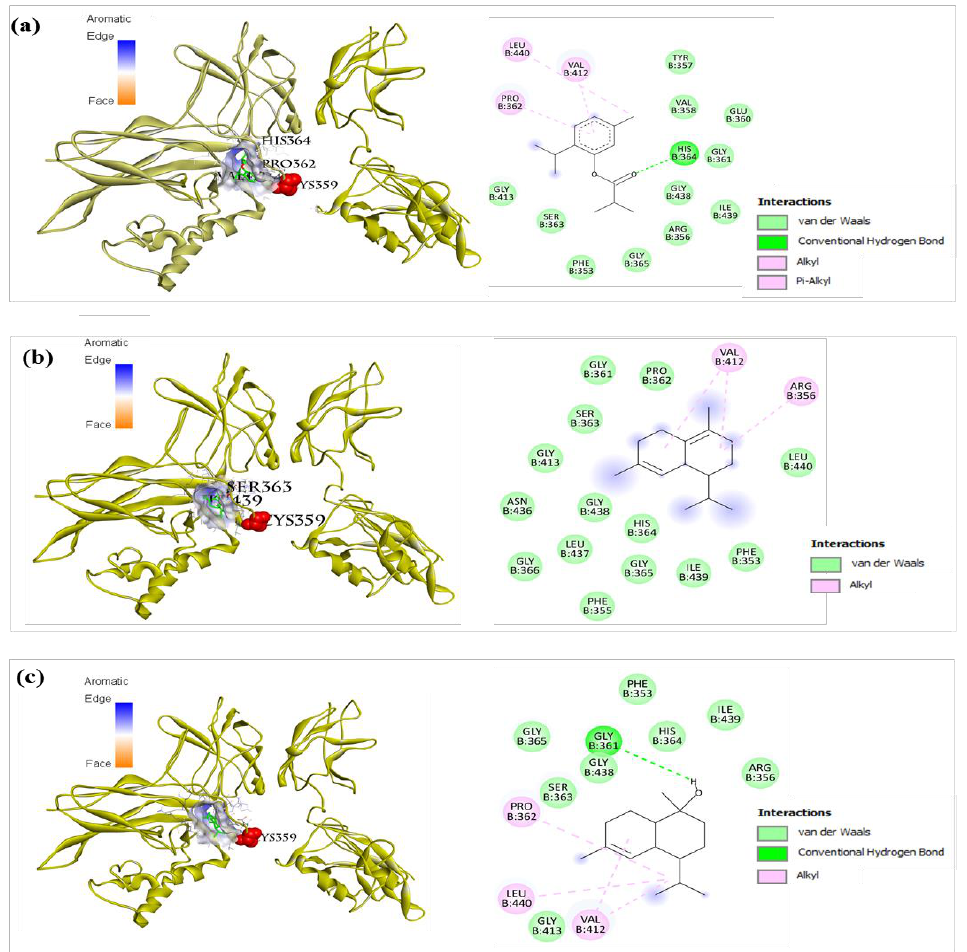
Figure 11. Docking analysis of compound 20 , 23 , and 27 with NF- κ B p50-p65. ( a ) Compound 20 (left: 3D, right: 2D) showed pi-alkyl interaction with Val412, alkyl interaction with Pro362 and Leu440, and hydrogen bonding with His364 of NF- κ B (PDB ID: 1VKX). ( b ) Compound 23 (left: 3D, right: 2D) showed alkyl interaction with Val412 and Arg356, and van der Waals interactions with Phe353, Phe355, Gly361, Pro362, Ser363, His364, Gly366, Gly413, Gly365, Asn436, Leu437, Gly438, Ile439, and Leu440, of NF- κ B (PDB ID: 1VKX). ( c ) Compound 27 (left: 3D, right: 2D) showed alkyl interaction with Pro362, Val412, and Leu440, and hydrogen bonding with Gly361 residues of p50 (PDB ID: